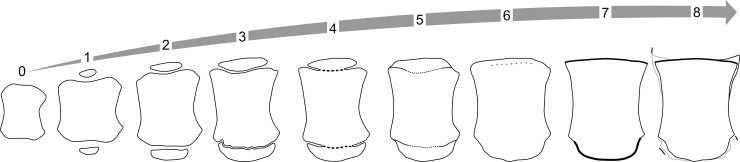
Skeletal ossification scores of the long bones and metacarpal bones.The endochondral ossification progression of the 2nd metacarpal (M2) through 8 different stages. Stage 0 shows no secondary ossification center with no development at either the proximal or distal ends. Stage 1 shows the beginning of the secondary ossification centers. Note the difference in width of the ossification center compares to the diameter of the metacarpal and how thin the secondary ossification center is (less than 50% of the surface). Stage 2 shows an increase in width and depth of the secondary ossification center, that is between 50–80% of the width of the metacarpal. Stage 3 shows the width of the secondary ossification center to be >80% of the metacarpal physis with a reduction in physeal space but it is still fully open. Stage 4 shows the formation of osseous bridges between the metacarpal and the secondary ossification centers but consolidation is <50% of the total extension. The ends remain open, fusion is incomplete. Stage 5 shows the ghost hypermineralized line of where the joining of the secondary ossification center has occurred at least over 50% of the total surface extension. The ends may remain slightly open or fissure be fully consolidated. Stage 6 full closure of growing plate with complete remodeling of the secondary ossification center with the area showing <50% to no visible ghost line. Stage 7 shows the flattening of the physeal surfaces of the metacarpal with accentuated pointed edges. Stage 8 shows degenerative bone or cartilage changes associated with the metacarpal with the presence of either osteolysis or proliferation. In extreme cases calcification of the surrounding cartilage maybe visible.